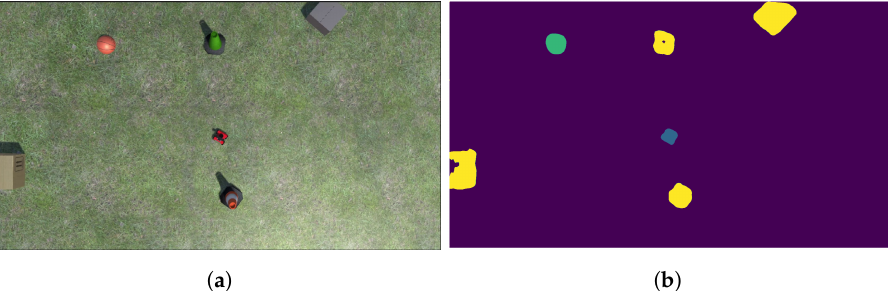
Figure 9. Graph of mean intersection over union (mIoU) over each epoch. A similar graph to the pixel accuracy, although notice the more realistic range.